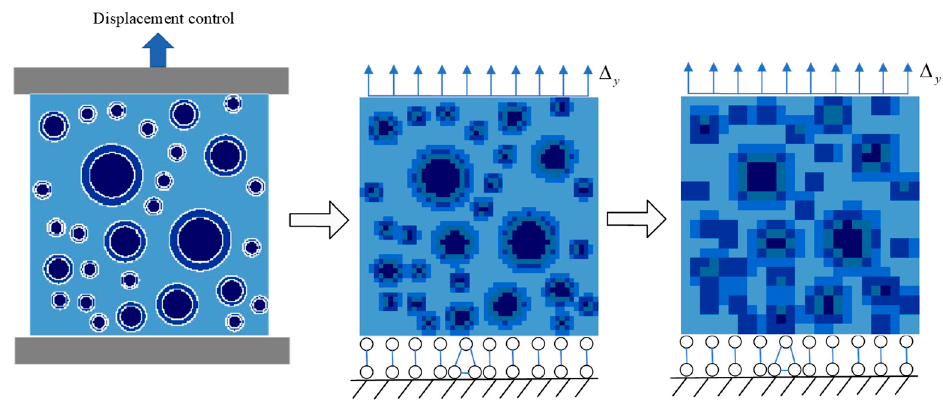
Figure 7. Load model.